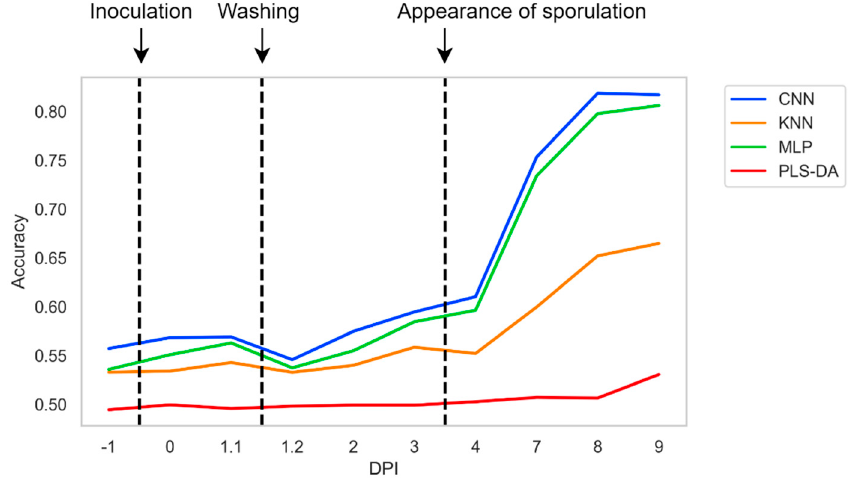
Figure 5. Classification accuracy between control and downy mildew inoculated discs in grapevine after different DPI (days post inoculation) using different machine learning models: Convolutional Neural Network (CNN), k-Nearest Neighbour (KNN), MultiLayer Perceptron (MLP) and Partial Least Square-Discriminant Analysis (PLS-DA). For each DPI, each of the models was trained, using for training the disc spectra preprocessed with reflectance, Savitzky-Golay, a disc-level standardisation and discarding extreme wavelengths. The times of inoculation, washing and appearance of the first sporulation are indicated by vertical lines, separating the different